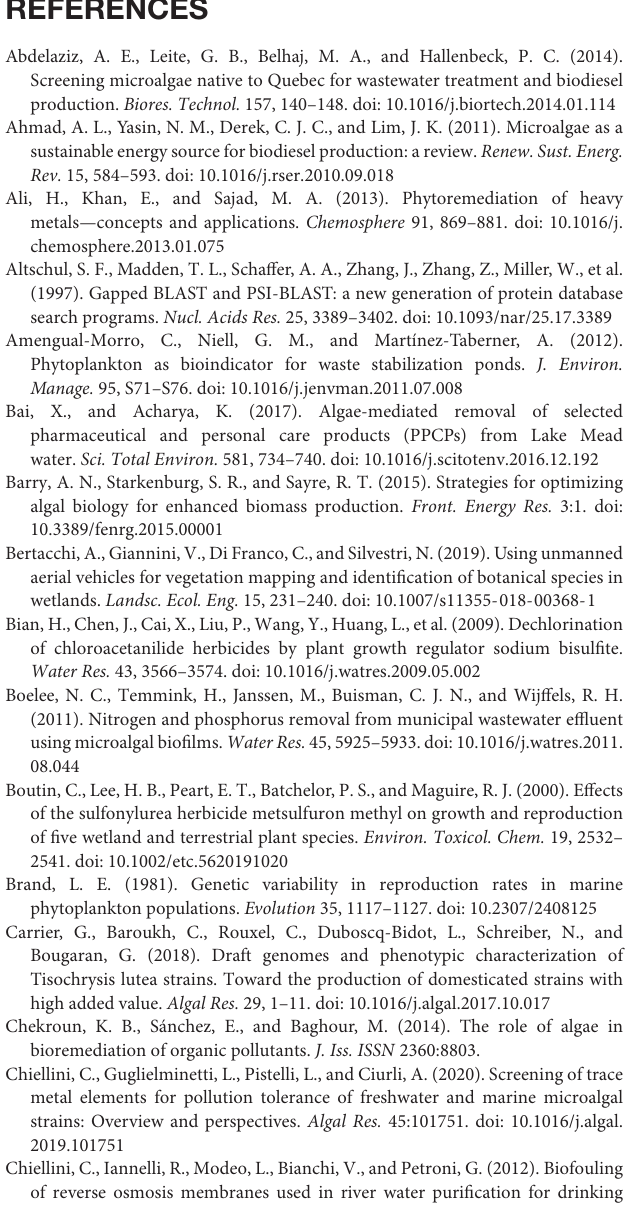
(1-week) of the experiment for each microalgal strain. Standard error bars are reported in the figure. Supplementary Figure 2 | Total chlorophyll and carotenoids contents related to the metal tolerance tests, expressed as µ g ml − 1 of algal culture. T -test has been applied to compare the effect of the metal respect to the control (C). The following convention for symbols indicating statistical significance were used: ns: p > 0.05; *: p ≤ 0.05; **: p ≤ 0.01; ***: p ≤ 0.001; ****: p ≤ 0.0001. Supplementary Figure 3 | OD 750 value measured after 1 week exposure at As and Ni. T -test has been applied to compare the effect of the presence of the metal with the control (C). The following convention for symbols indicating statistical significance were used: ns: p > 0.05; *: p ≤ 0.05; **: p ≤ 0.01; ***: p ≤ 0.001; ****: p ≤